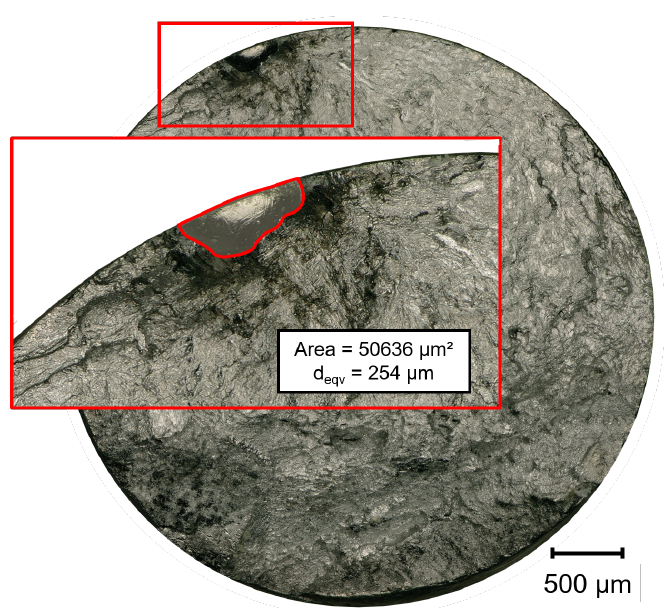
Figure 7. Gas pore at surface as representative surface defect.